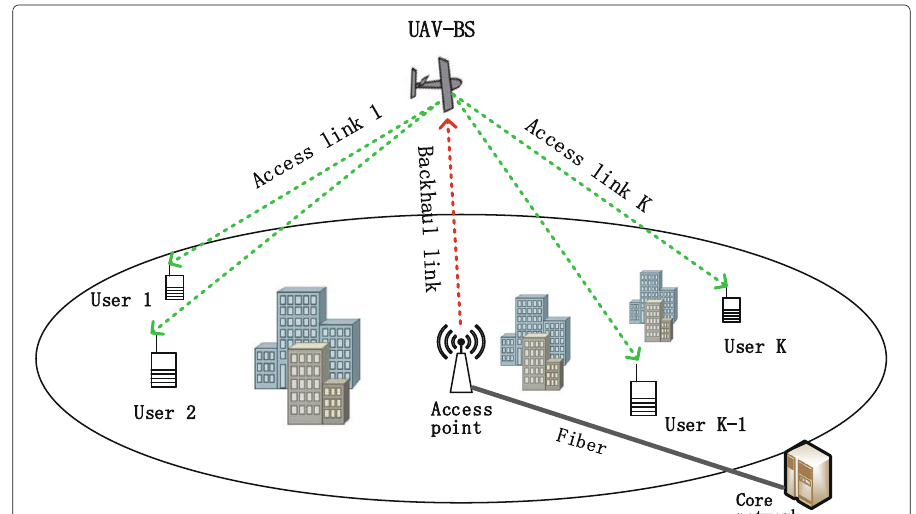
Fig. 1 A UAV-BS under in-band backhaul